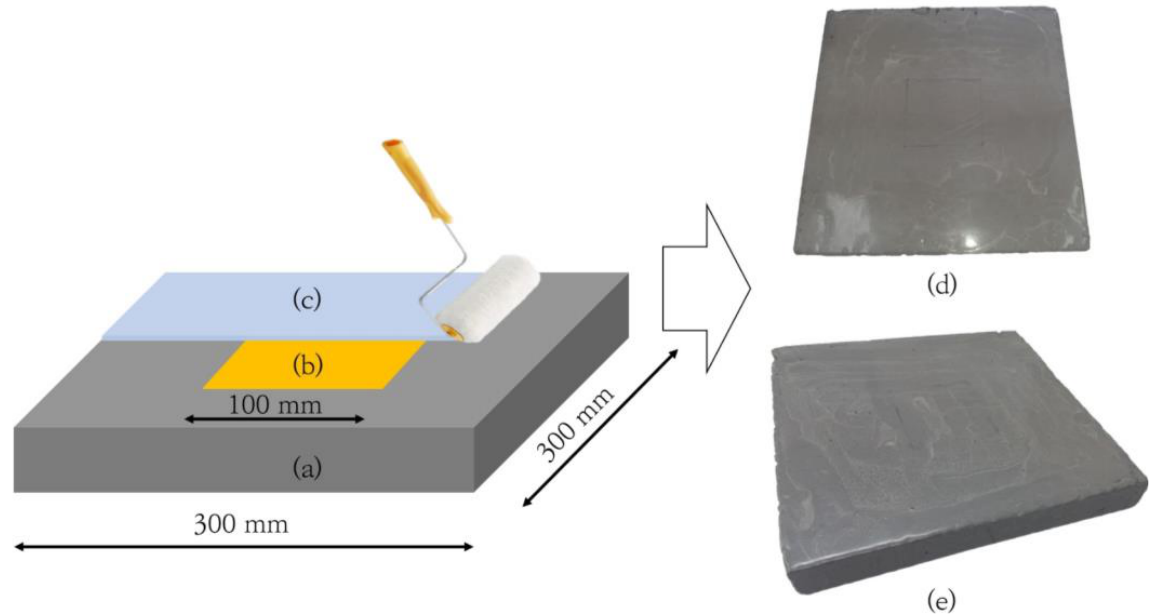
Figure 2. Specimen fabrication. ( a ) Concrete block, ( b ) thin polyethylene film, ( c ) coating layer, and ( d , e ) are the top- and side-view photos of the fabricated specimen.